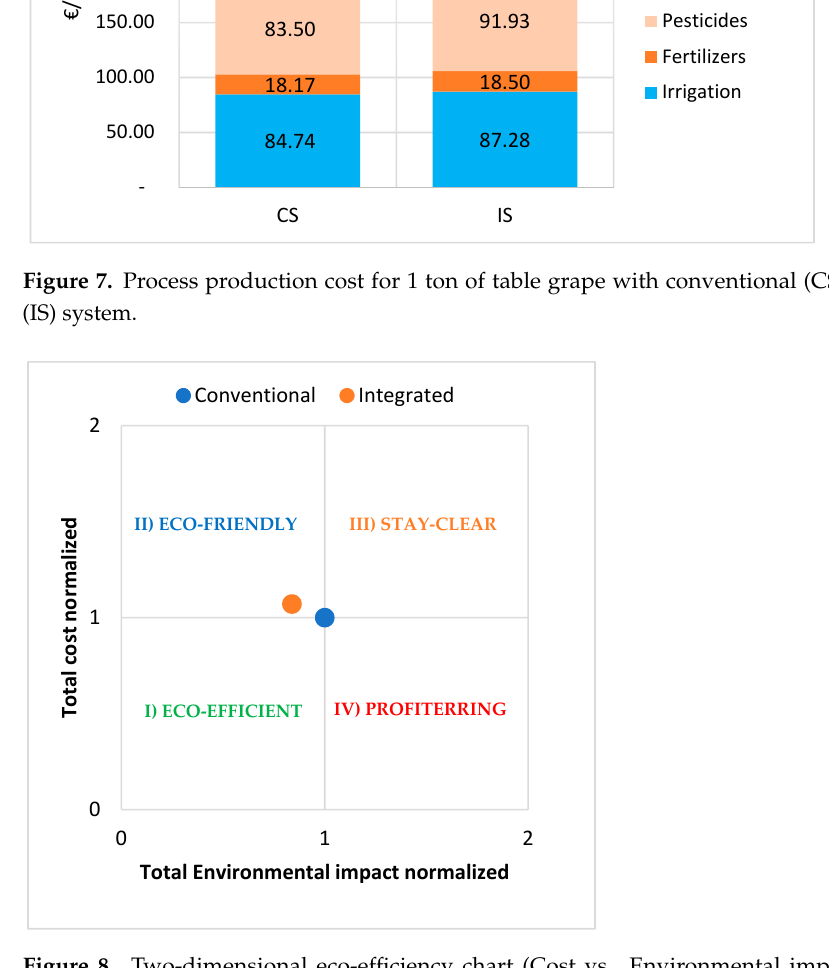
Figure 8. Two-dimensional eco-efficiency chart (Cost vs. Environmental impact) showing the relative positioning of 1-ton table grape production with conventional (groundwater) and integrated (groundwater + reclaimed water) irrigation. Zones: (I) Eco-efficient—both cost and environmental (III) Stay clear—both cost and environmental footprint are increased, (IV) Profiteering—cost